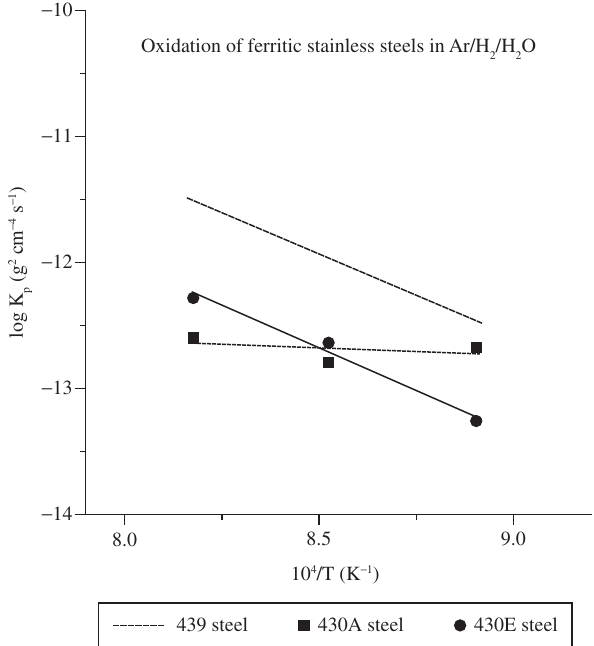
Figure 5. Arrhenius plot of the parabolic oxidation constants of 430A, 430E and 439 steels in Ar/H